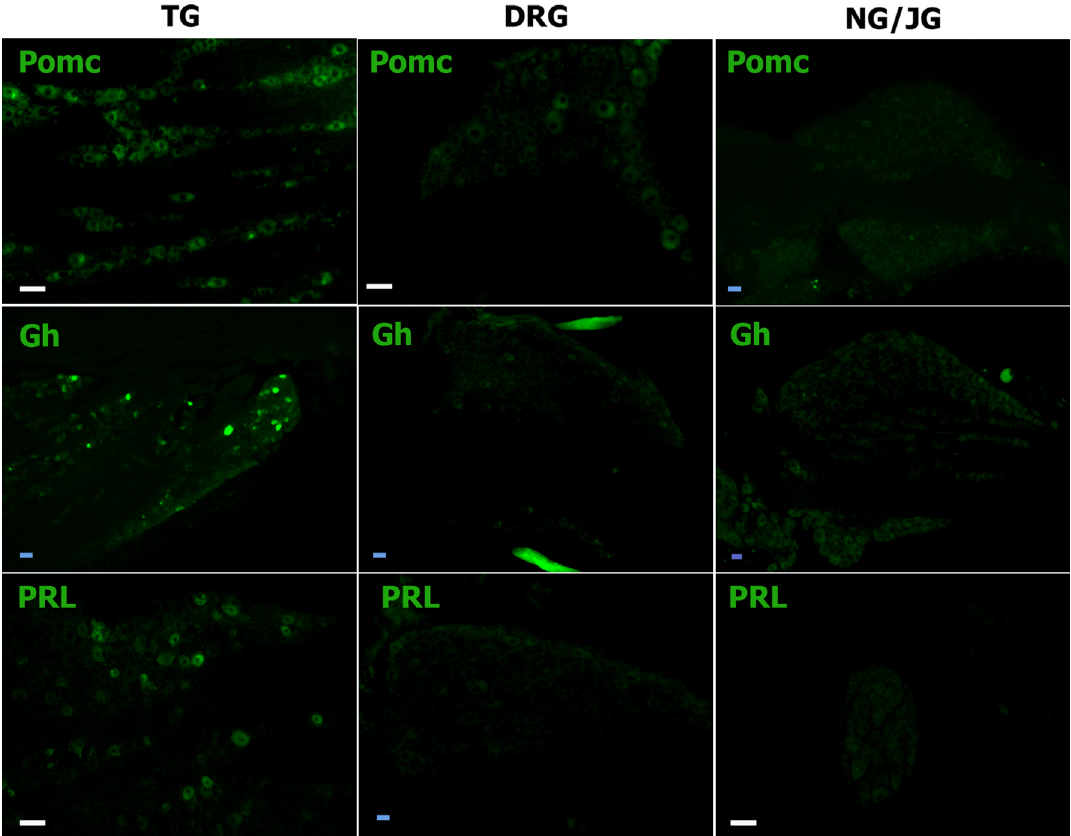
Figure 4. Expression of Prl, Gh and Pomc gene products in DRG, NG/JG and TG. TG, DRG and NG/JG cryo- sections harvested from naïve mice and labeled with Pomc ( upper panels ), Gh ( middle panels ) and Prl ( bottom panels ) antibodies. Type of sensory ganglion is noted above upper panel. White bars correspond to 40 μm on images captured with × 20 objective. Blue bars correspond to 40 μm on images captured with 10 ×